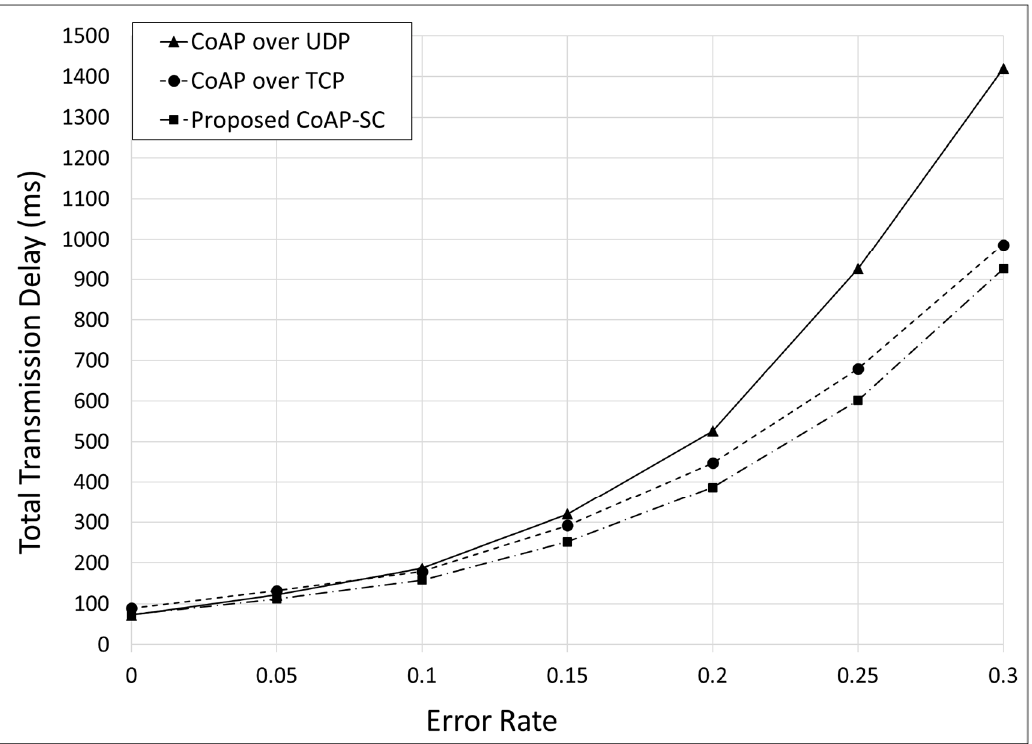
Figure 23. Total transmission delays for different error rates.